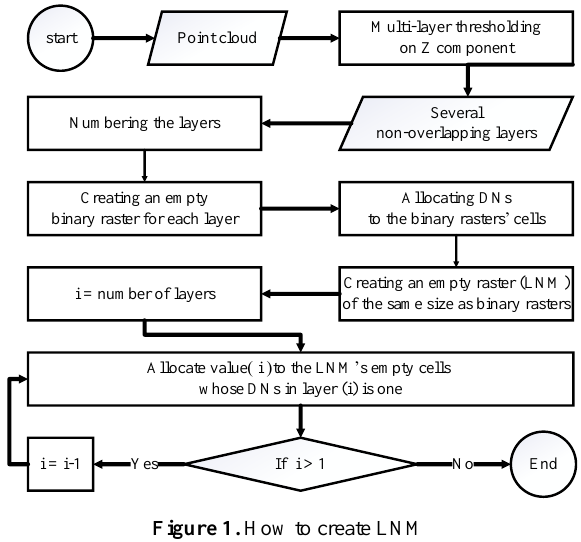
Figure 1. How to create LNM As LNM stores the top layer for each cell, it is expected that the DNs of the raster correspond to the ceiling height. Because the ceilings are almost horizontal, a sudden and constant decrease in their height would signify a place where a door might be. So, to detect these regions, the LNM will be segmented based on its DNs. In the segmentation process, a segmentation matrix which is a raster whose DNs show cells' segment IDs, will be created. After that, unique values of DNs will be detected. Then, a mask (a binary image) will be produced for each unique value (i: 1 ≤ i ≤ number of layers-1). The value of this mask would be one only for those pixels with DNs in the range of [i, i+1]. An erosion operator is employed on the masks to remove small parts, most of which belong to noises. Then, the pixels with value one in the masks will be labelled. In the labelling process, if there is at least a way between a pair of pixels, and this way only passes through pixels of one value, both pixels of the pair will be labelled with the same value. However, if this condition is not met, these two pixels' labels differ. Figure 2 shows an example of how a mask will be labelled. In this figure, the pixels in yellow and